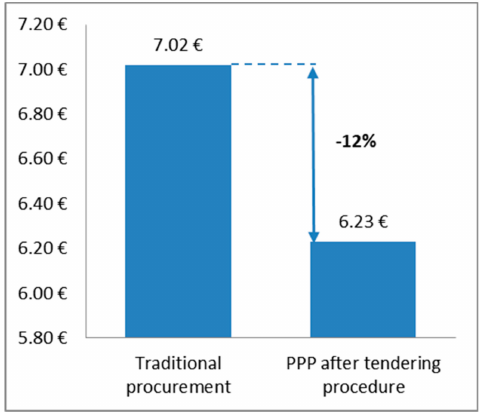
Figure 3. Value-for-Money analysis after tendering procedure presented as a unitary charge per square meter per month. Source: Authors’ calculation (based on data available in Appendix A: Table